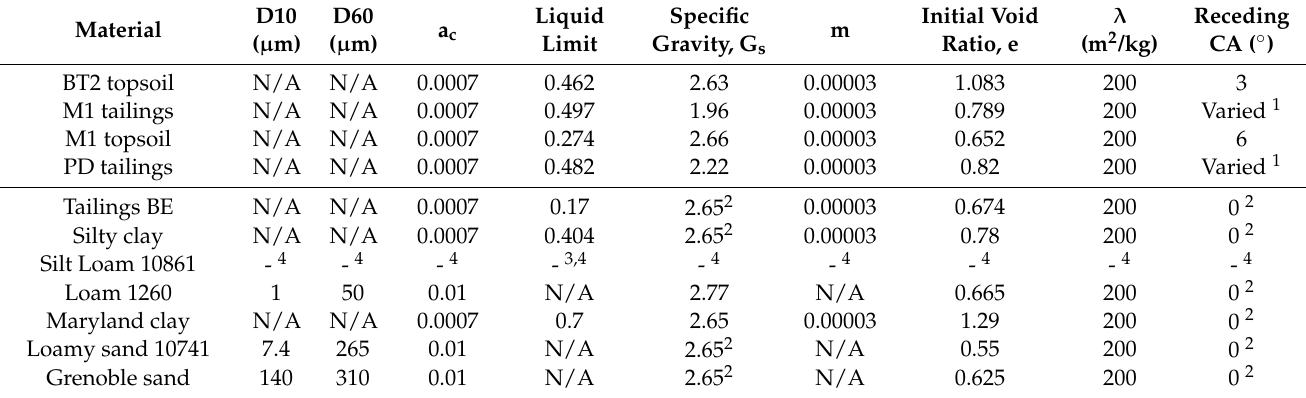
Table A7. Parameters used in the modified Kovacs model (MK) for each material: 10% and 60% mass passing particle diameters (D10, D60), parameter a c , liquid limit, specific gravity, parameter m, initial void ratio, parameter λ , and receding contact angle